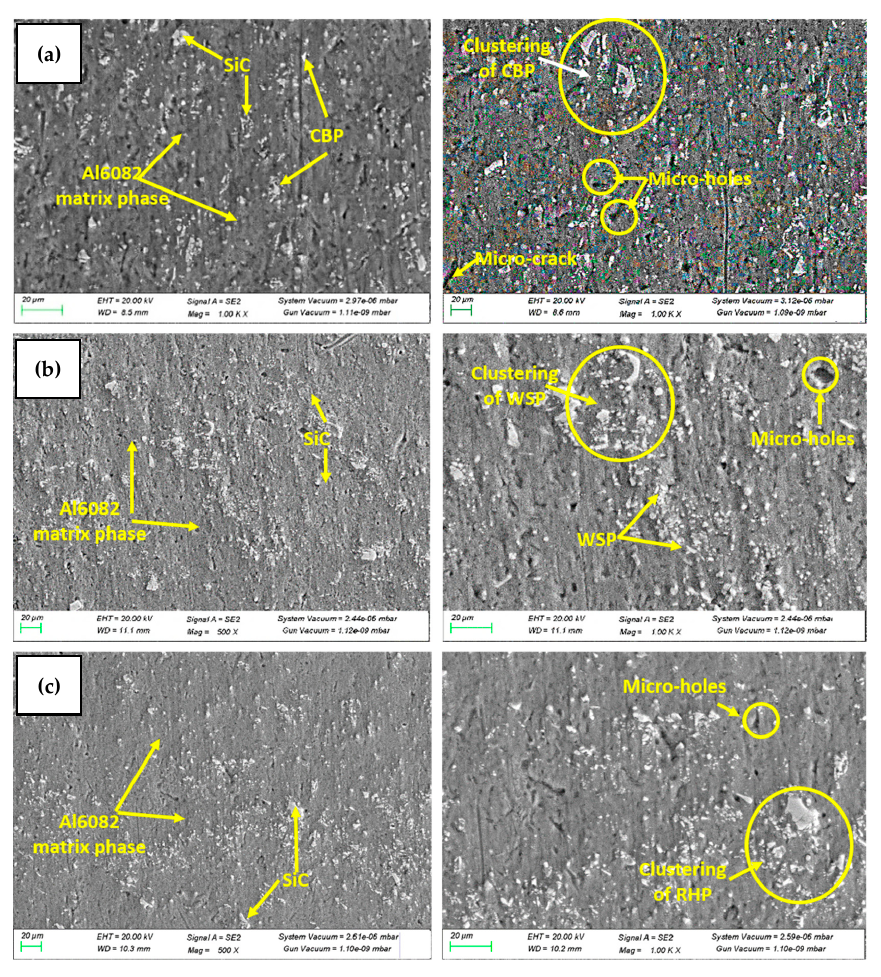
Figure 4. FESEM images of ( a ) Al6082/2% SiC/2%CBP, ( b ) Al6082/2% SiC/2%WSP, ( c ) Al6082/2% SiC/2%RHP.